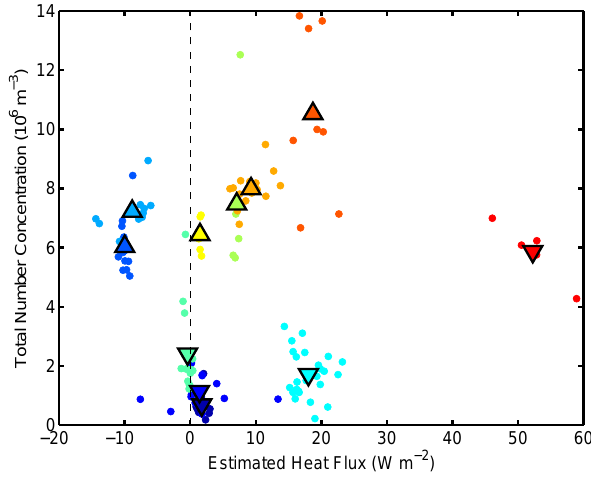
Fig. 11. Individual two-minute estimates of total bubble concentra- tions and daily means plotted against the heat flux at the sea-air or sea-ice interface; symbols and colours are as in Fig.